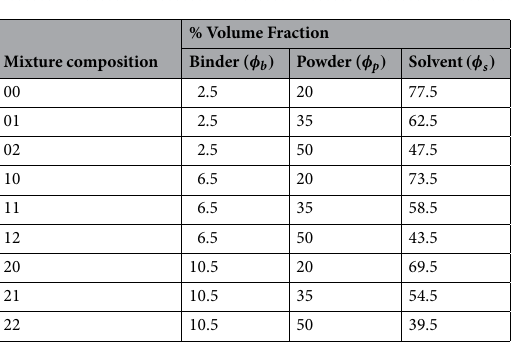
Figure 2. Sample image of the 3D depth profile of liquid coating.